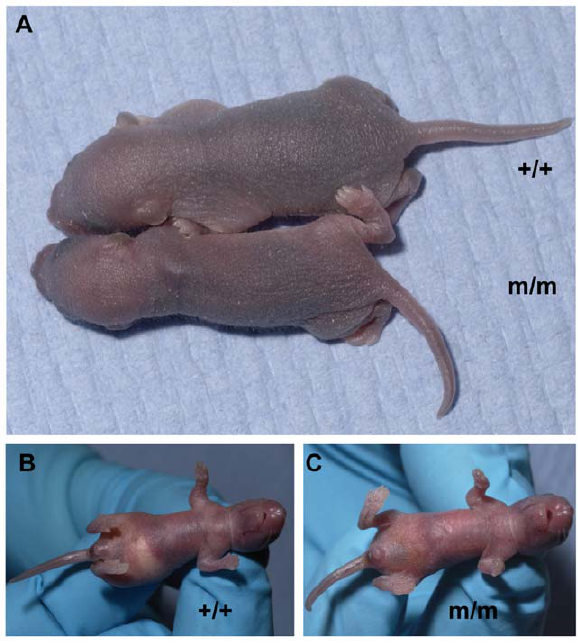
Figure 2. Phenotype of homozygous Foxf2 W174R pup compared with wildtype. A , A noticeable difference in gross size can be seen by 3 days of age in mutant pup. B&C , In contrast to the homozygous knockout, the homozygous Foxf2 W174R individuals appear normal at birth, although the amount of milk consumed (arrow) is reduced compared to wildtype littermates.